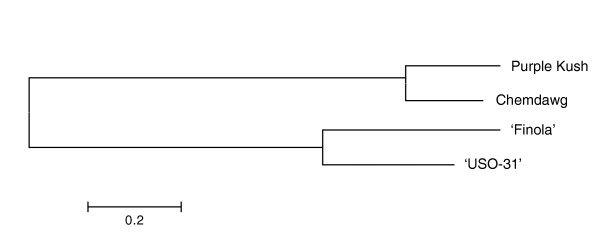
Neighbour-joining tree for two hemp cultivars and two marijuana strains. The tree was plotted in MEGA5 [71] using the maximum composite likelihood of SNV nucleotide substitution rates, calculated based on the concatenated SNV sequences in each variety, as a distance metric. The topology of the tree reveals a distinct separation between the hemp and marijuana strains.